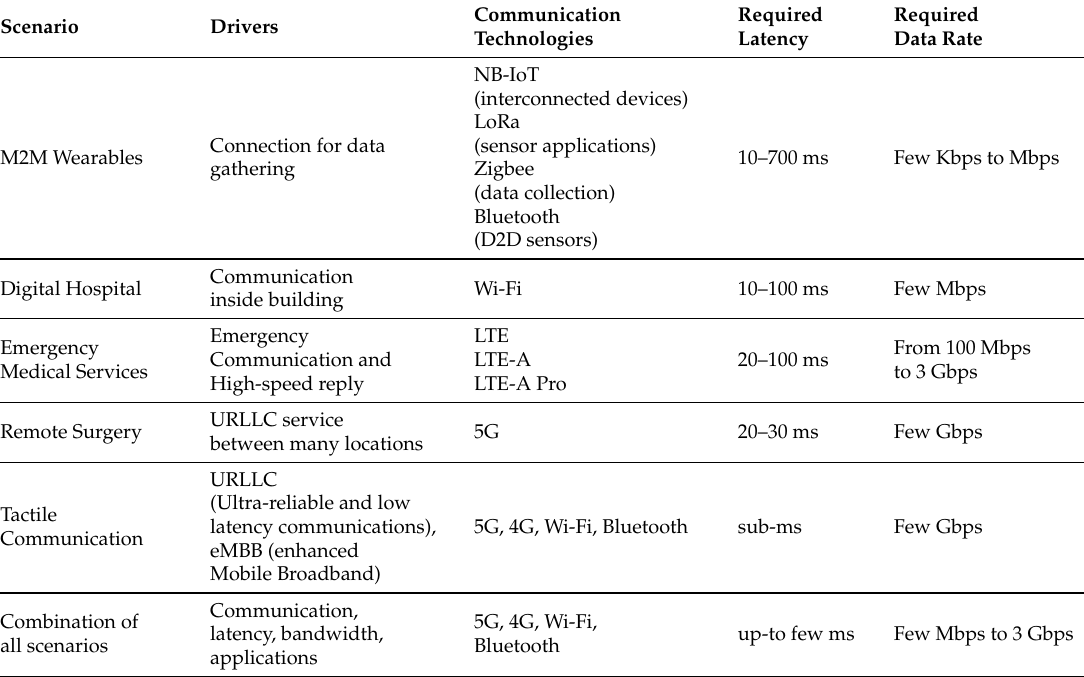
Table 4. Summary of numerous scenarios for smart